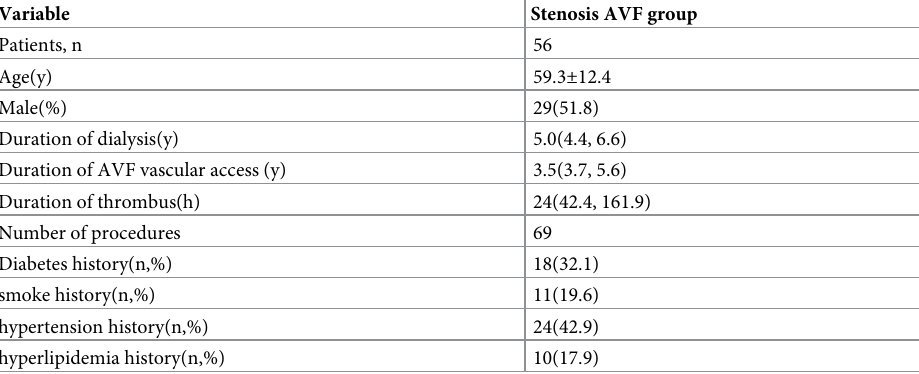
Table 1. Demographic data and clinical variables of involved patients’